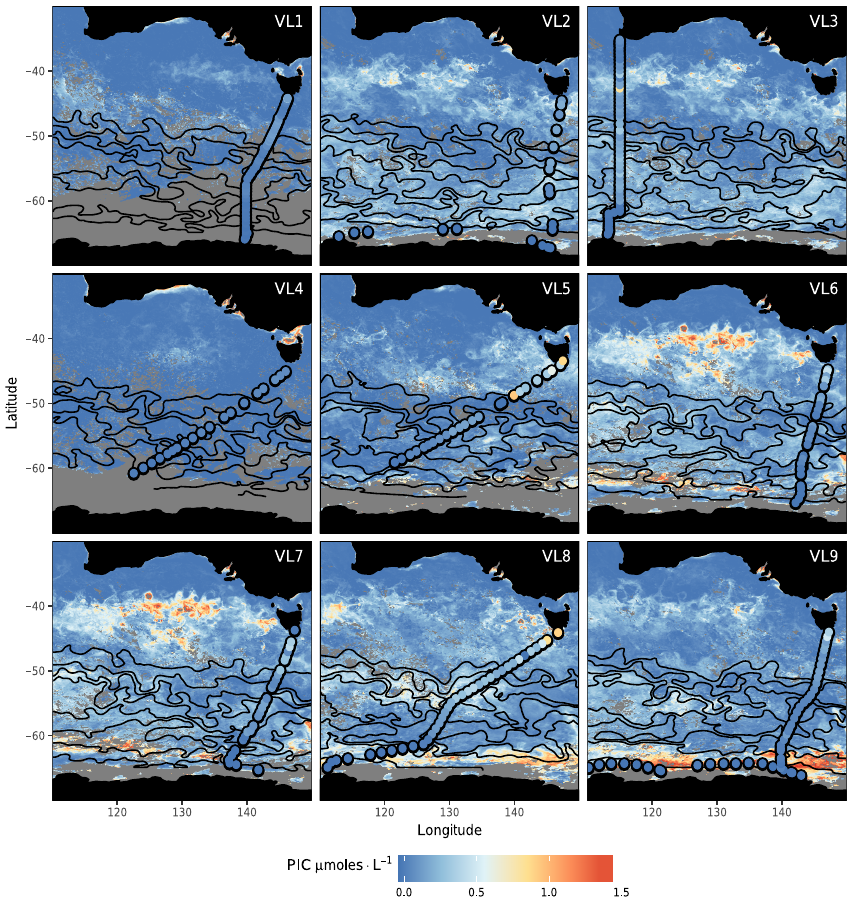
Figure 5. Maps comparing ship-based distributions of coccolithophore PIC distributions (PIC01; coloured dots) with satellite PIC esti- mates (SPIC; background colours) for each voyage leg. The SPIC estimates are averages for the month preceding the start of each voyage leg. Contour lines indicate dynamic height-determined frontal positions for the week preceding the each voyage leg (see Fig. 1 for front